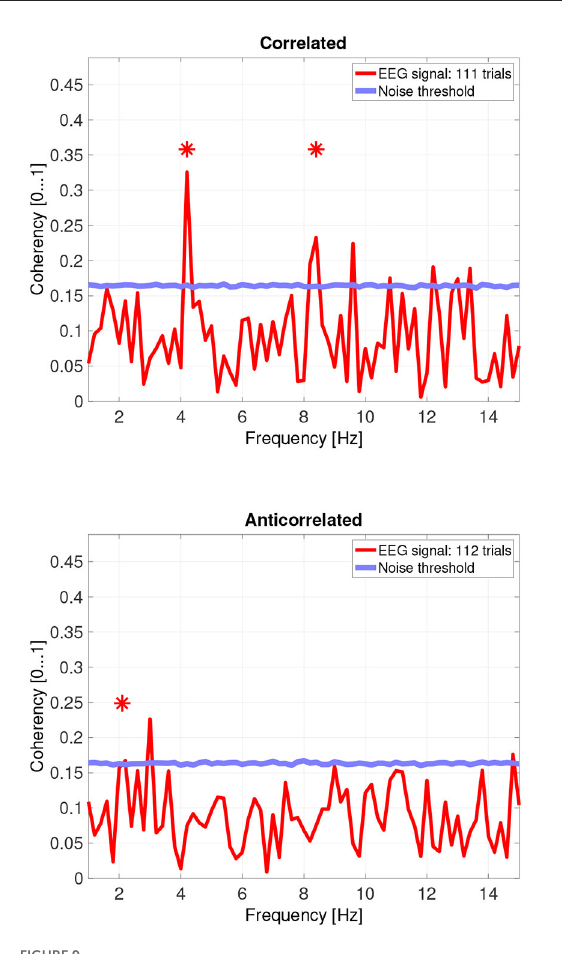
FIGURE9 Coherency values from participant AO. The stars above the peaks indicate successful detection of the harmonic of the stimulus frequency. Note that the coherency plots are in phase space, and that they are not showing spectrum: a higher coherency value imply a stronger relationship to the stimulus. The “Noise threshold” is created with 10,000 data sets having the same number of trials, with the trials containing only white noise. The line shows the 95 th percentile of the coherency values created from these synthetic data